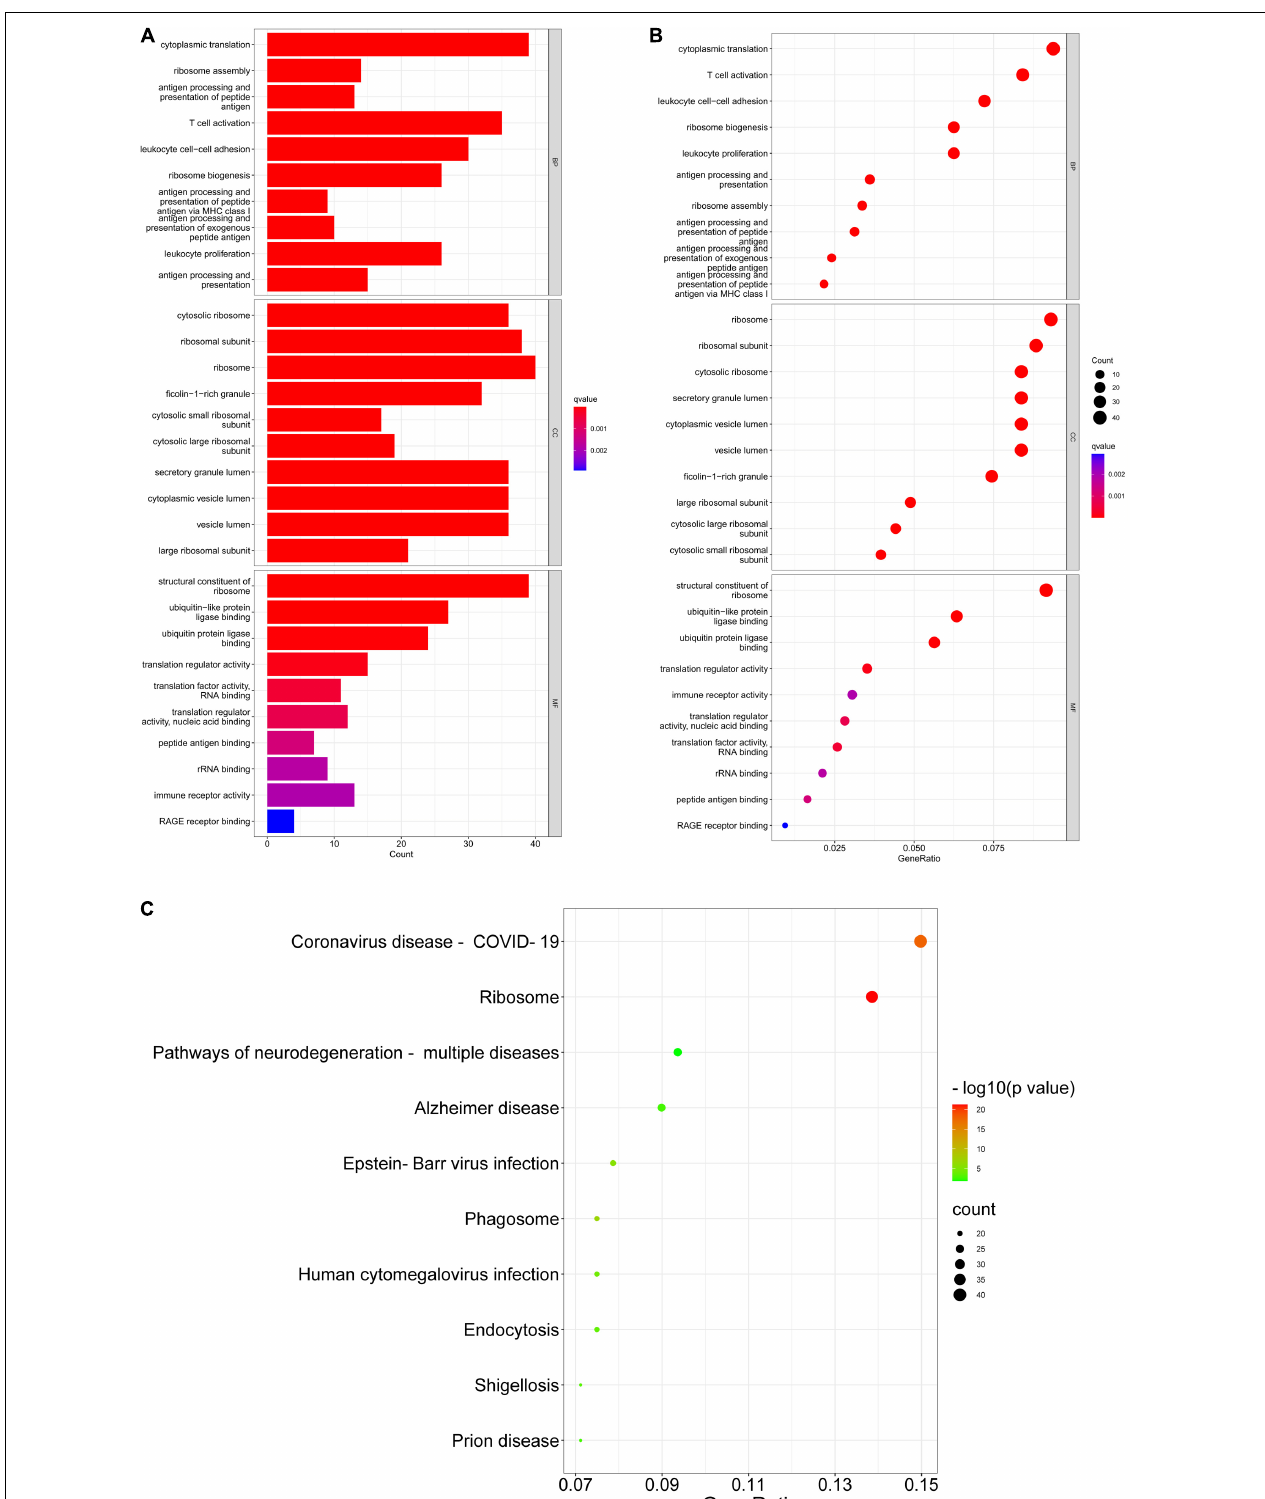
FIGURE 5 | GO enrichment and KEGG pathway. (A,B) GO enrichment analysis of DEGs. (C) KEGG pathway analysis of DEGs.